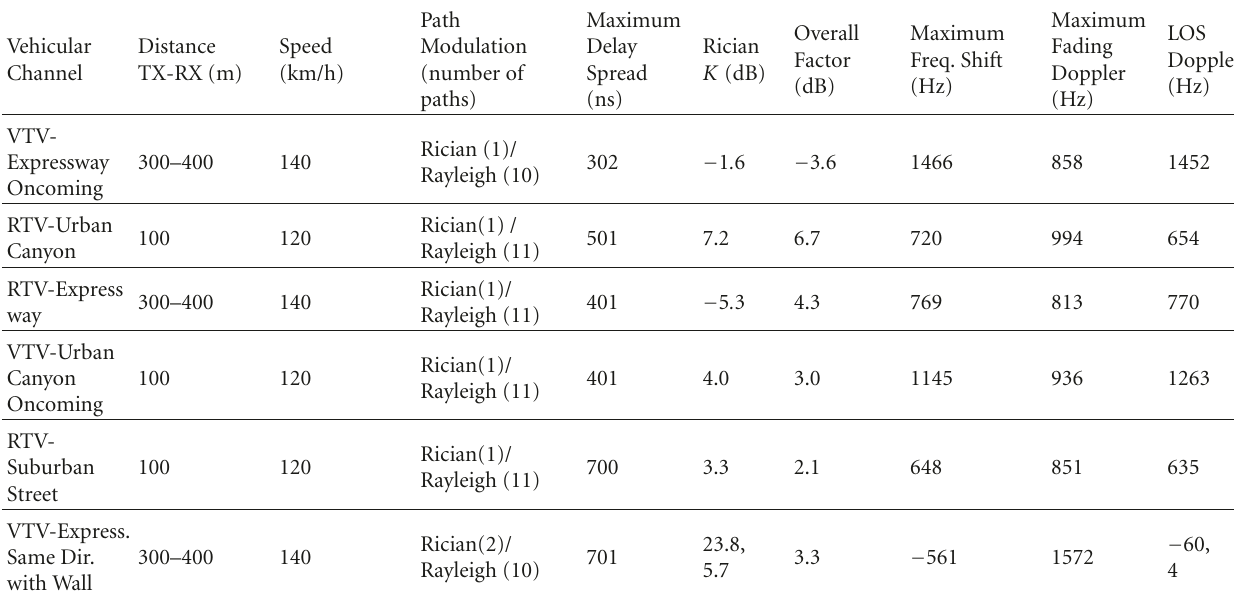
Table 1: Main characteristics of the vehicular models.